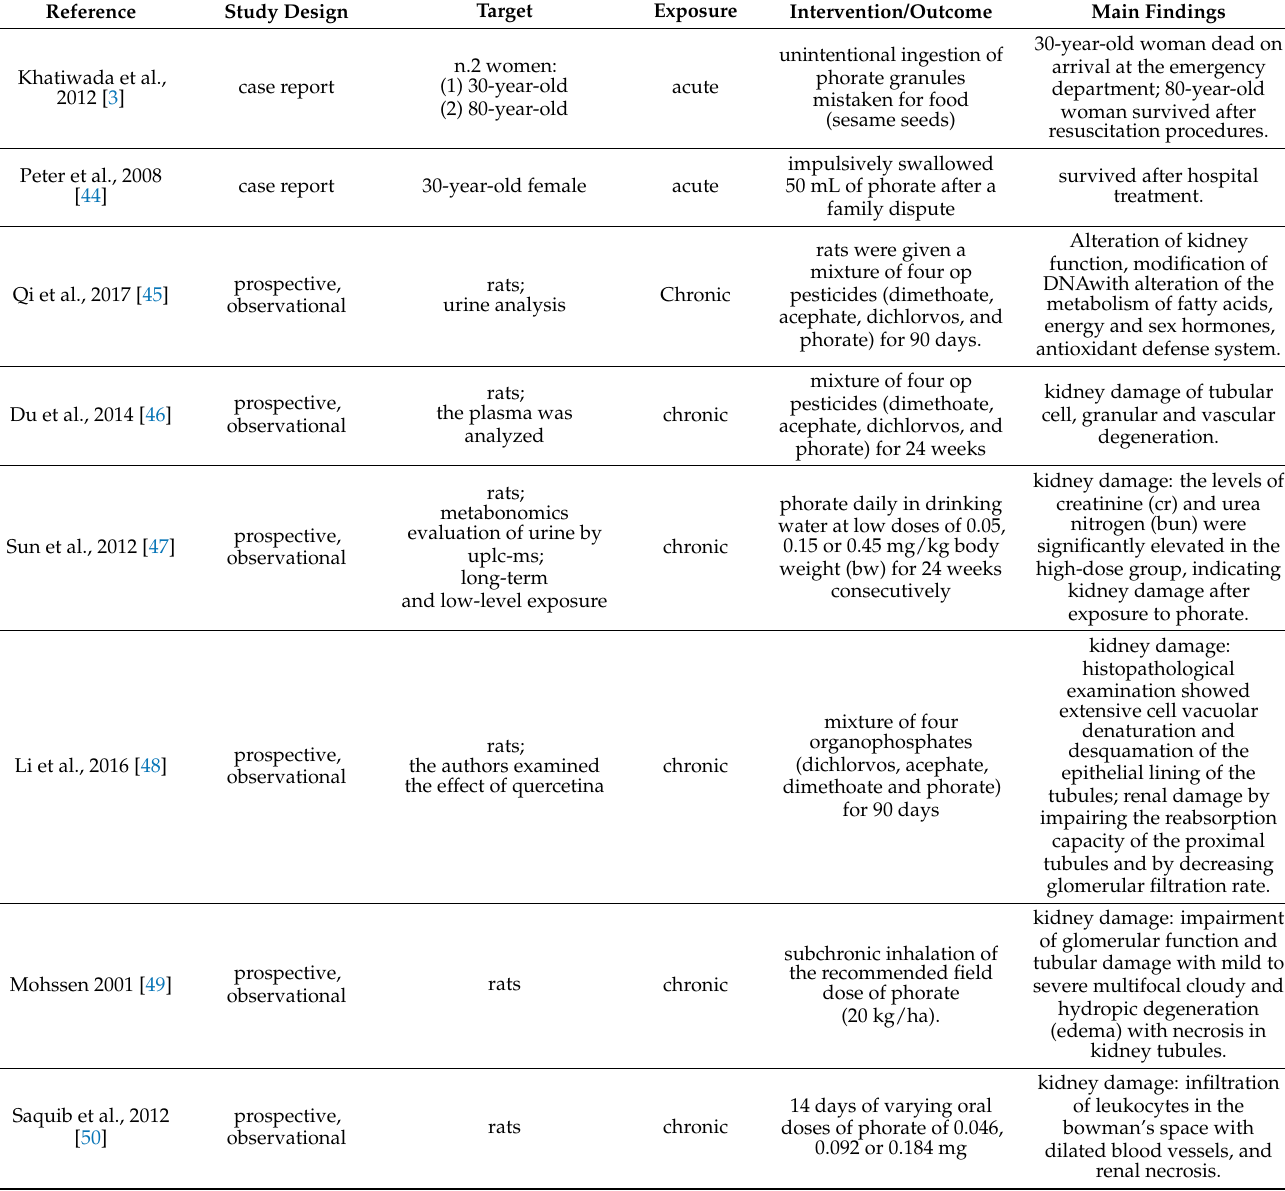
Table 1. Characteristics of eligible studies (animals and